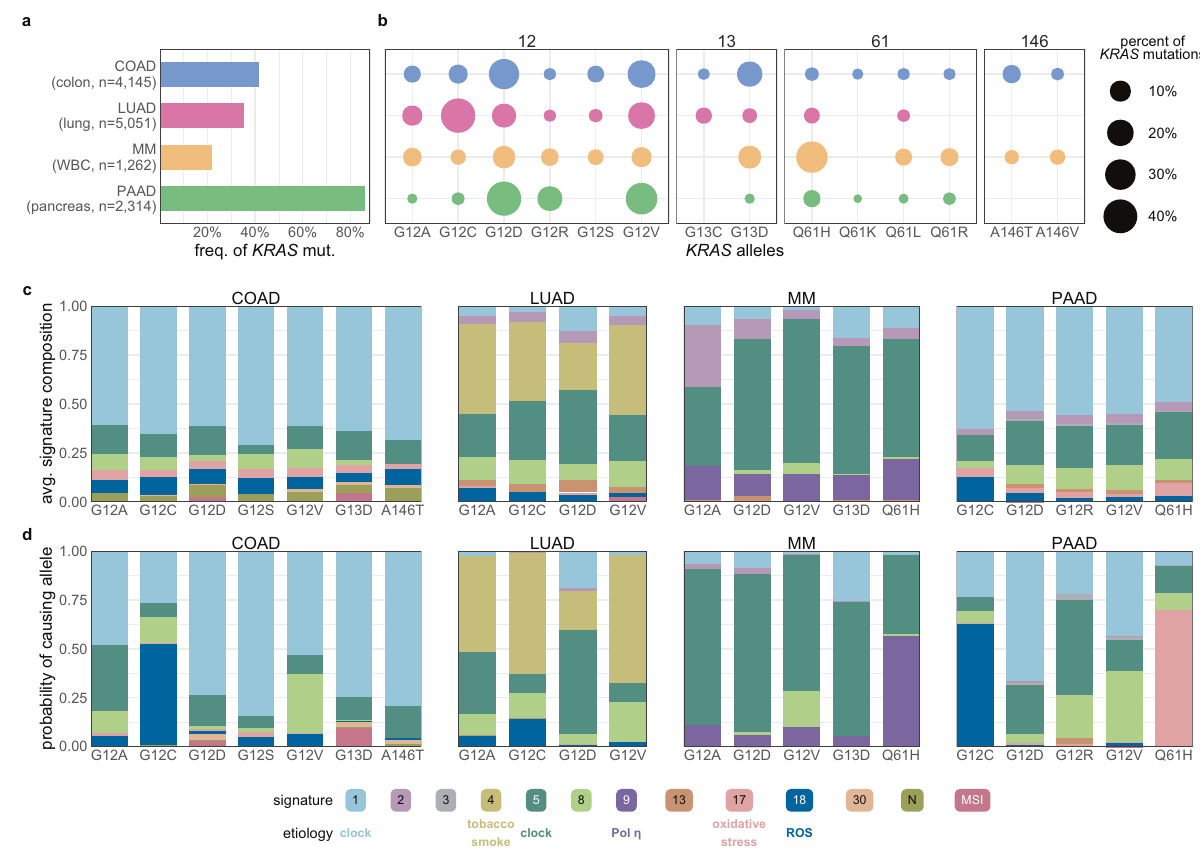
Fig. 1 The contribution of mutational processes to KRAS mutagenesis. a The frequency of KRAS mutations in each cancer. b The distribution of KRAS allele frequencies at the four hotspots, codons 12 (left), 13 (middle-left), 61 (middle-right), and 146 (right) in each cancer. The size of the circle re fl ects the percent of KRAS mutations that are the indicated allele in each cancer. Each cancer is assigned a different color. The number of tumor samples whose sequencing data was collected for this study is indicated along the y -axis. c The average composition of mutational signatures in tumor samples grouped by KRAS allele. Each color represents a different mutational signature. Mutational signatures of know etiology are annotated. d The average probability of each mutational signature to have caused the KRAS mutation in a tumor sample. This value accounts for the level of each mutational signature in the tumor sample, and the ability of the mutational signature to cause the indicated KRAS allele. In c and d , only KRAS alleles found in at least 15 tumor samples of the cancer type are included. Source data are provided in the Source data fi